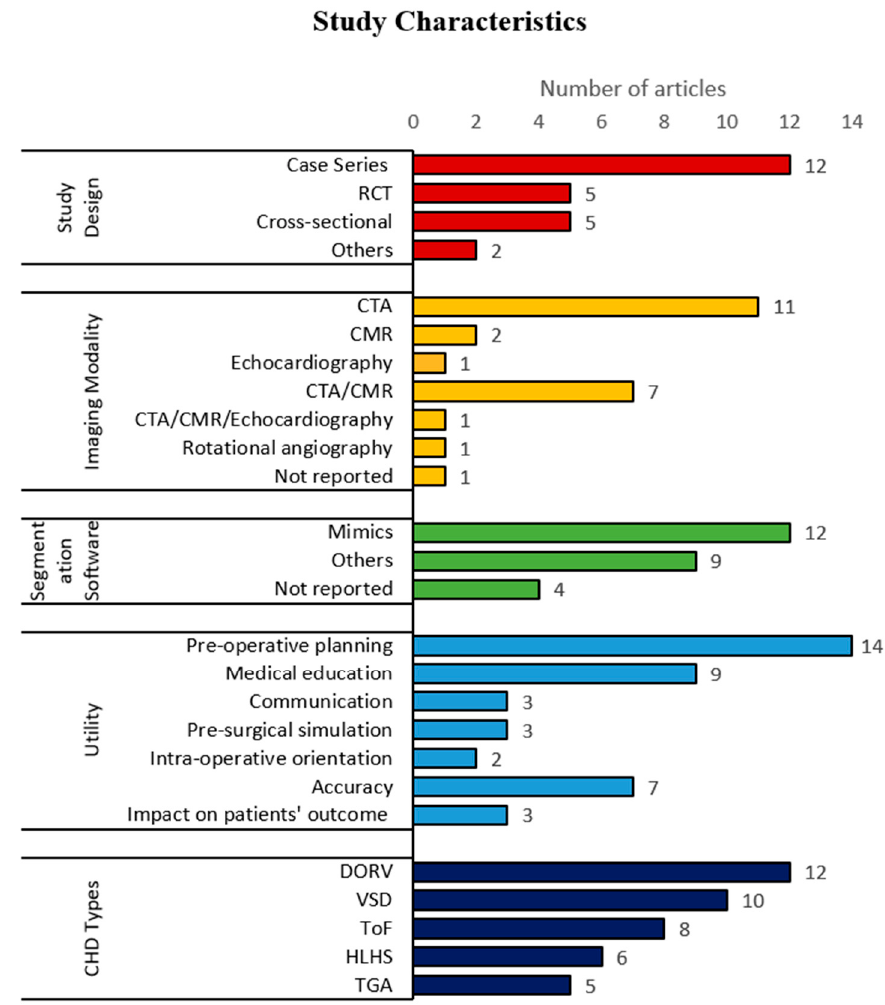
Figure 2. Horizontal histogram of the characteristics of the included studies. CHD, congenital heart disease; CMR, cardiac magnetic resonance; CTA, computed tomography angiography; DORV, double outlet right ventricle; HLHS, hypoplastic left heart syndrome; RCT, randomized controlled trial; TGA, transposition of great arteries; ToF, Tetralogy of Fallot; VSD, ventricular septal defect.